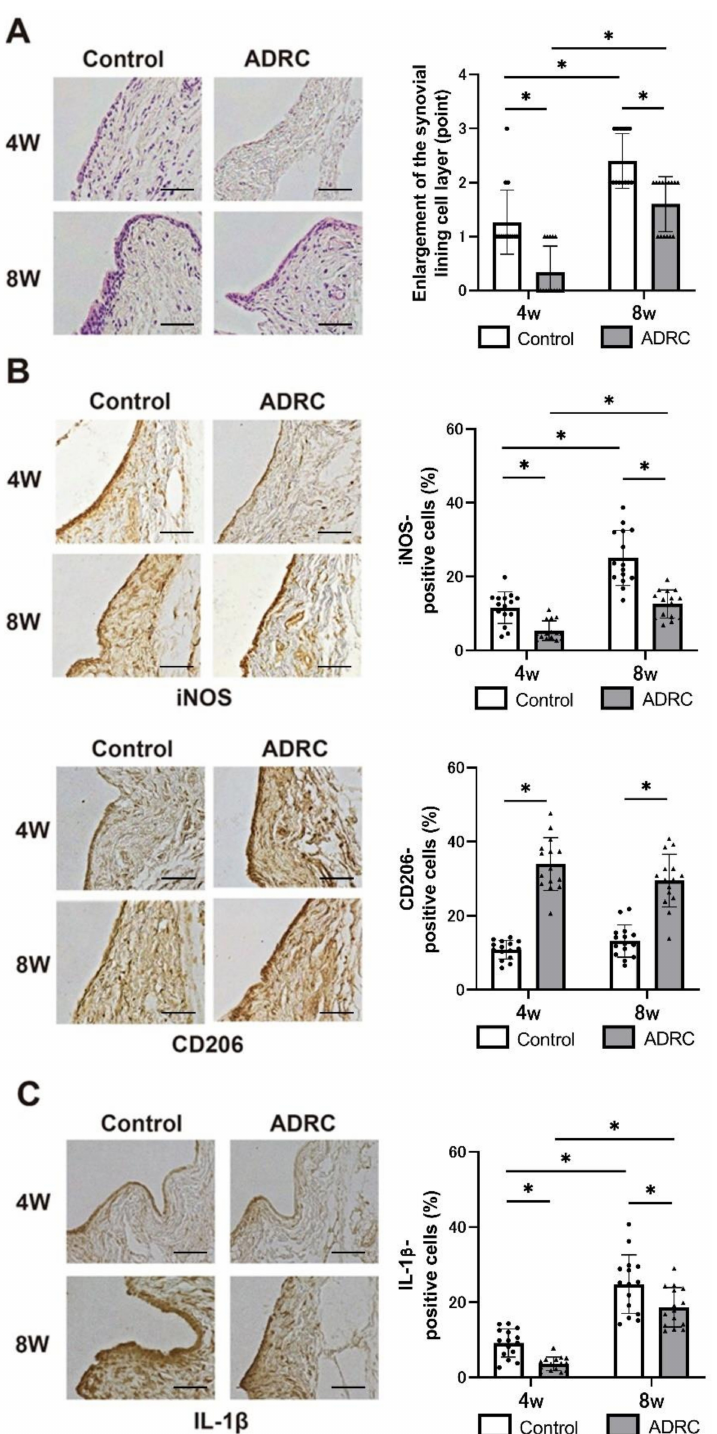
Figure 5. Histological and immunohistochemical analyses of the synovium. ( A ) Hematoxylin and Eosin staining. Images were taken at 100 × . ( B ) Immunohistochemistry results for iNOS and CD206. ( C ) Immunohistochemistry results for IL-1 β . Graphs show the results of the synovial lining cell layer and the ratio of the positive cells to the total cells for each protein at four and eight weeks after transplantation. Asterisk indicates a statistically significant difference. Grading of enlargement of the synovial lining cell layer was based on the method of previous report [38]. Scale bars = 100 µ